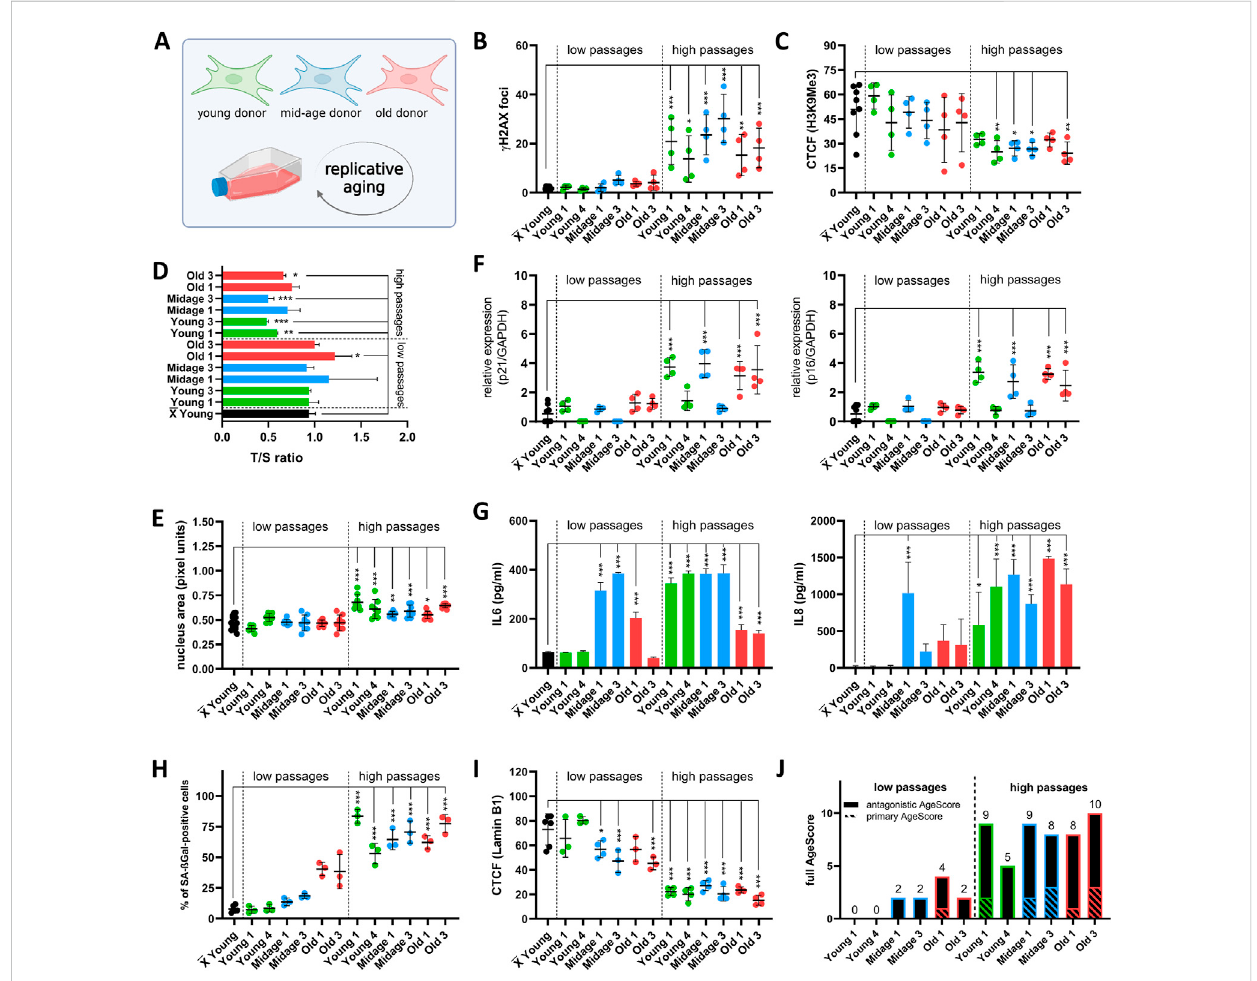
young, mid-age and old donors were replicative aged. (B – I) X (cid:1) = Mean value of all young donors. (B) Quanti fi cation of γ H2A.X in fi broblasts in high passages ( p > 35) in comparison to the mean of all Young low . Amount of γ H2A.X foci per cell increased in all cells in high passages. [ n = 4 (each